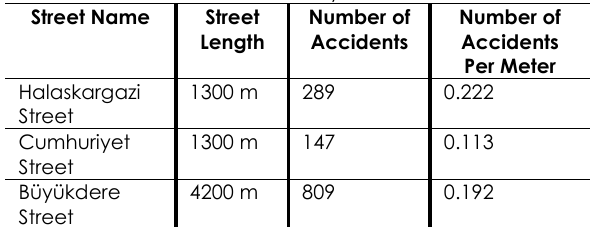
Table 3. Number of accidents by